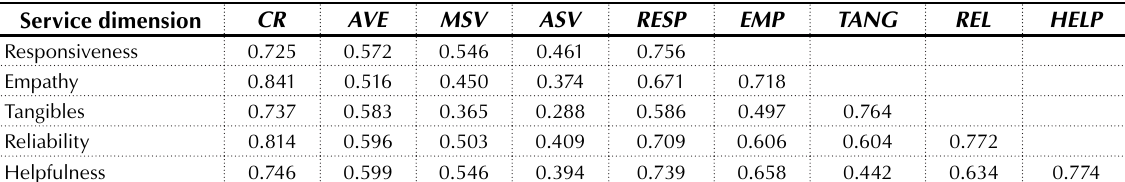
Table 2. Convergent and discriminant validity indices Service dimension